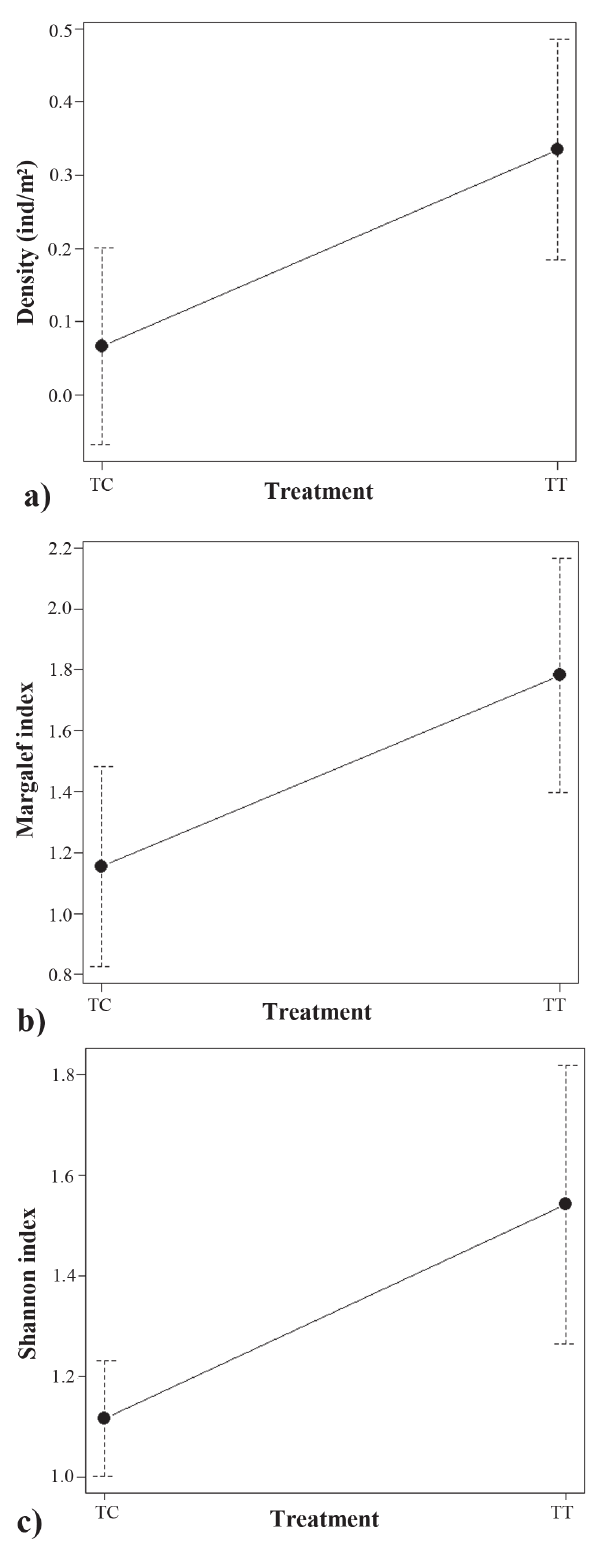
Fig. 2. Average values and confidence interval (IC individuals’ density, Shannon and Margalef Indices for each treatment, structurally complex streams (TT) and simplified stream (TC).